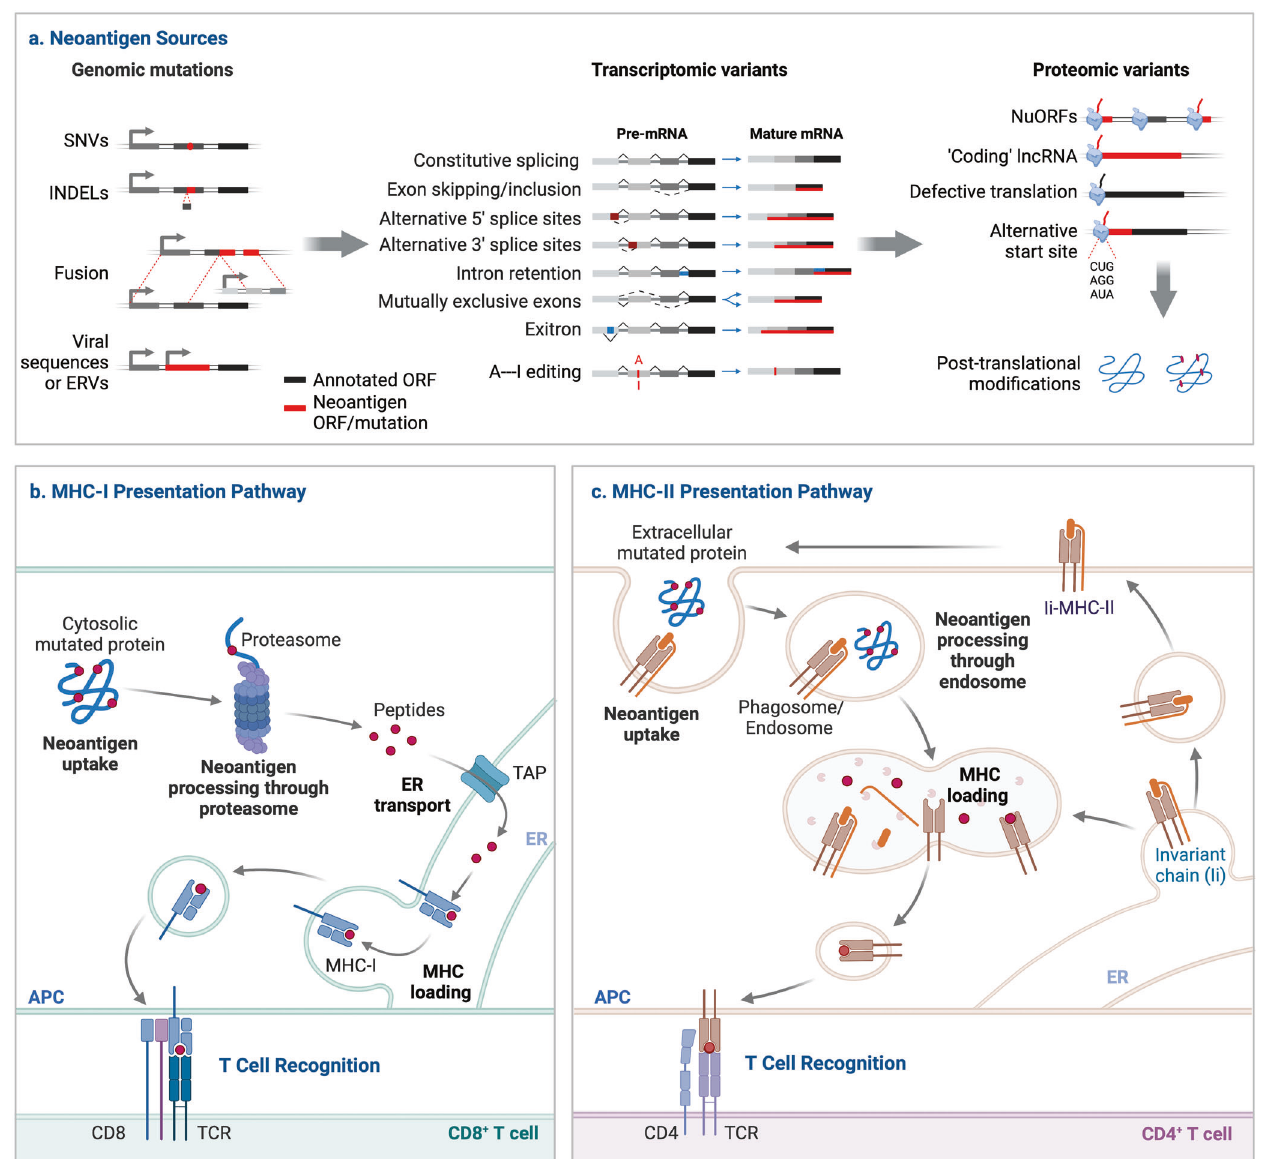
Fig. 2 Overview of the neoantigen production and presentation. Neoantigens can develop at the genomic level through SNVs, base INDELs and gene fusions, at the transcriptomic level through alternative splicing, polyadenylation (pA), RNA editing and allegedly non-coding regions, and at the proteomic level through dysregulated translation and PTMs. The integrated viral ORF is another source of neoantigens for cancers linked to viruses. The mutant peptides created by the proteasome-mediated breakdown of endogenous proteins are subsequently transported to the endoplasmic reticulum (ER) via transporters associated with antigen processing (TAP), where they may be loaded onto MHC-I. MHC-II dimers are assembled and bound to the invariant chain (Ii) in the ER. The Ii-MHC-II complex can be directly transported or sometimes indirectly internalized from the cell surface to the MHC-II compartment (MIIC), where the degradation of Ii by a series of endosomal proteases releases the MHC-II for binding a speci fi c peptide derived from a mutant protein broken down in the endosomal pathway. These pMHC complexes will then traf fi c to the cell surface where they are recognized by T